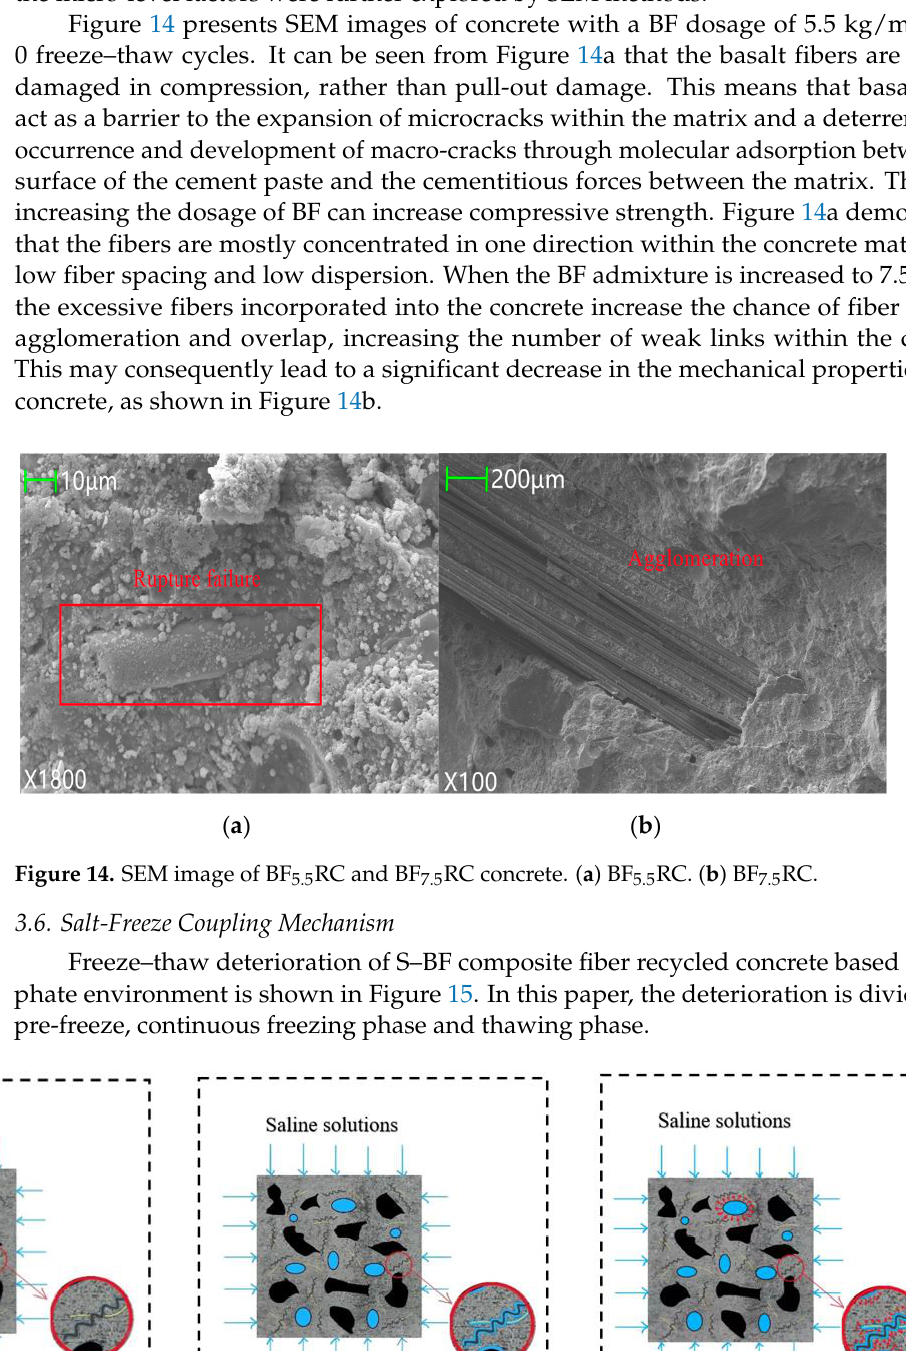
Figure 13. SEM image of NC and RC concrete.